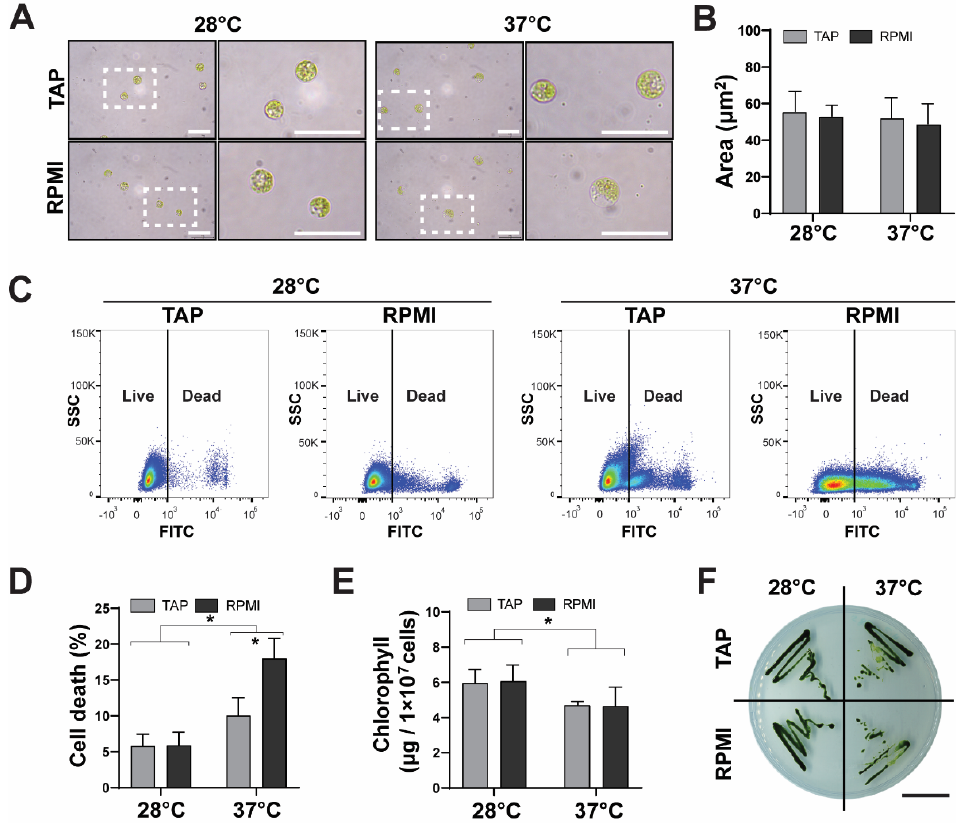
Figure 1. Effect of mammalian cell culture conditions on C. reinhardtii . Microalgae were cultured at 28 or 37 °C in TAP or RPMI for 24 h and key features were analyzed. Images of the microalgae show no major morphological changes ( A ). Cell area quantification shows no significant changes ( B ). Microalgae cell death was analyzed by FACS ( C ). Quantification shows that in both TAP and RPMI cell mortality was lower at 28 °C than 37 °C, being significantly higher for the cells cultured at 37 °C in RPMI ( D ). Chlorophyll content significantly decreased at 37 °C, independent of medium ( E ). When recovered, microalgae were able to proliferate in agar plates in all conditions ( F ). Scale bars represent 20 µm in ( A ) and 1 mm in ( F ). All assays were performed in at least three independent experiments and data are presented as average + standard error (SE). p ≤ 0.05 was considered as significant using a two-way ANOVA, with different letters implying statistical differences. * = p ≤